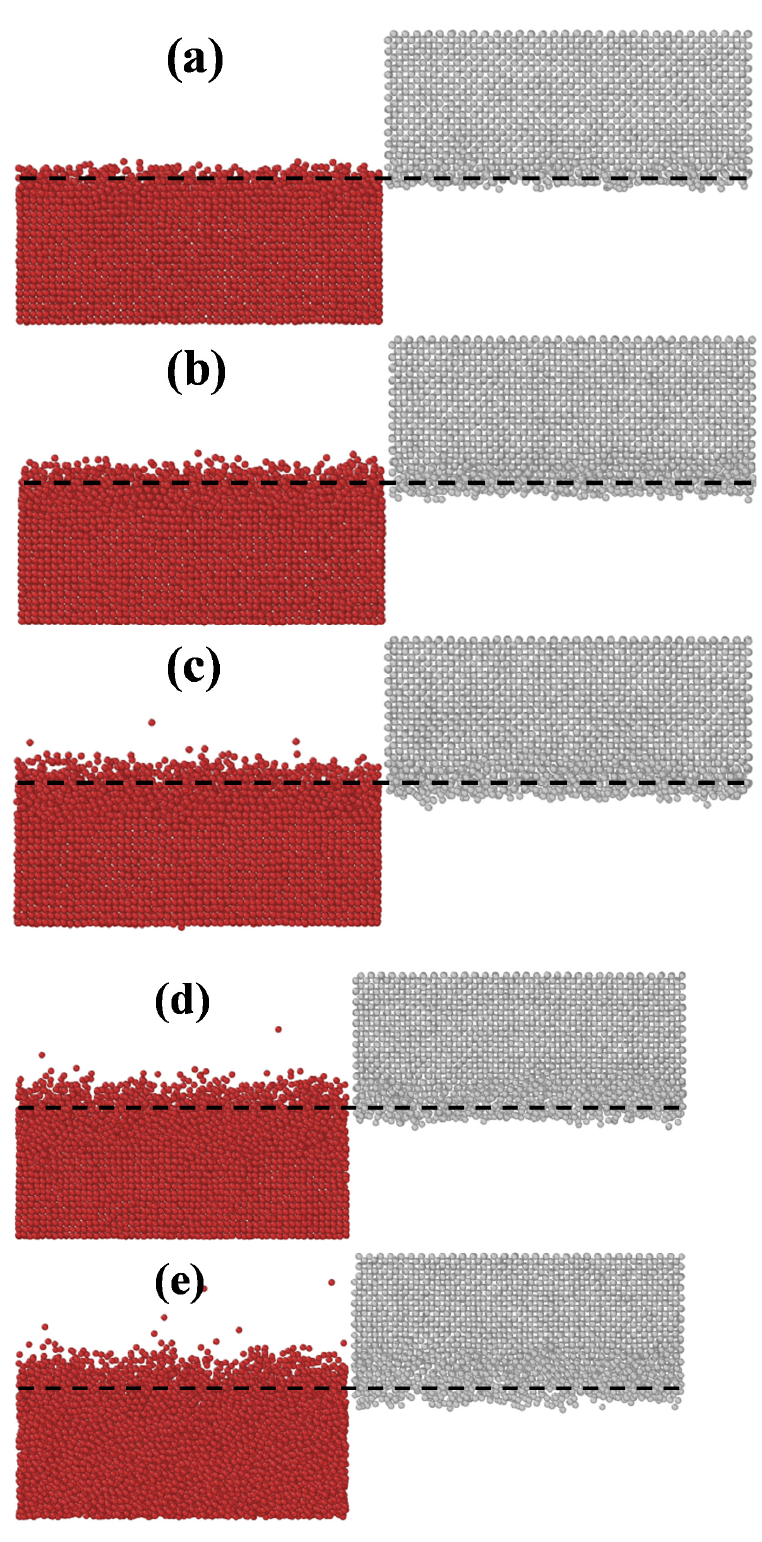
Figure 4. The W-Cu interfacial structures after simulation for 2 ns at different temperatures: ( a ) 900 K, ( b ) 1000 K, ( c ) 1100 K, ( d ) 1200 K, and ( e ) 1300 K. The red and gray atoms represent Cu and W atoms, respectively.